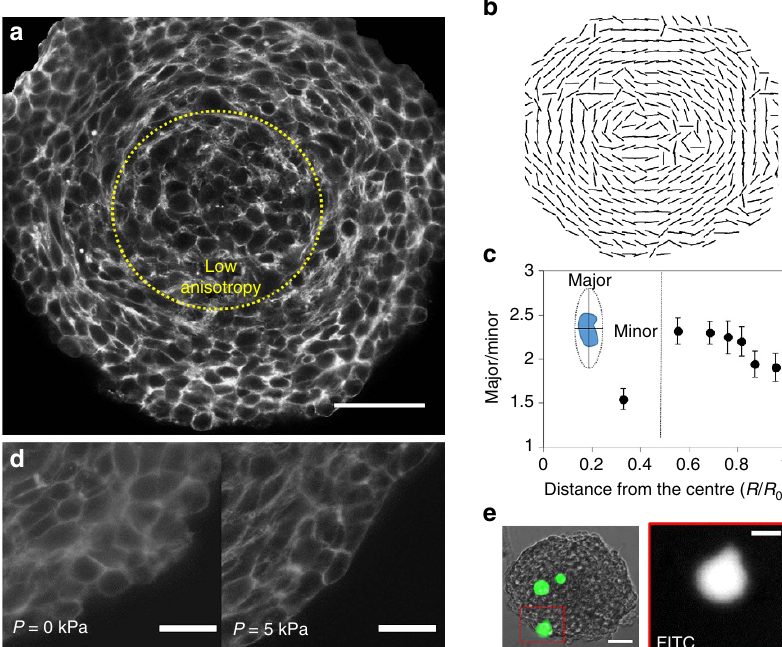
Figure 5 | Organization of cells within CT26 spheroids. ( a ) Confocal image of Phalloidin staining on CT26 spheroids at the equatorial plane. Yellow dotted circle divides a spheroid into a high anisotropy (major axis is perpendicular to radius; aspect ratio of 2–2.5) and low anisotropy zone (aspect ratio B 1.5). Scale bar, 50 m m. ( b ) Orientation of the major axis of cells at the equatorial plane. ( c ) Cell anisotropy has been estimated with the ratio of the major to the minor axis of the cell, as illustrated on the insert. Analysis of two axes has been performed using ImageJ and the fit ellipse function. Only cells with clearly marked cortical actin were used for the analysis. Data points ( N ¼ 177) were grouped together in bins, with the error bar being the s.e.m. and the position being the average R / R 0 position within the bin. The vertical line divides two zones: high anisotropy and low anisotropy zone. ( d ) Zoom-in on actin staining by the border of spheroids shows that cells at the surface are round and loosely bound, whereas after pressure is applied, the surface is well defined, and cells become more rectangular. Scale bar, 20 m m. ( e ) Bright-field/FITC image represents a spheroid with incorporated microbeads that are marked in green (FITC). Microbeads positioned at the surface of spheroids are highly deformed and represent a pear-like shape. Scale bars, 50 m m (bright field/FITC), and 20 m m (FITC).